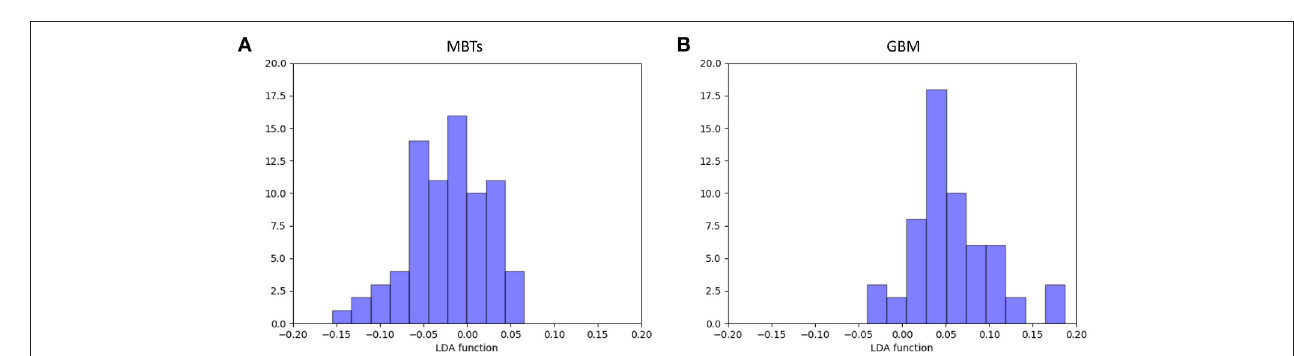
FIGURE 5 | Example of distributions of the LDA function of (A) MBTs and (B) GBM for one cycle.